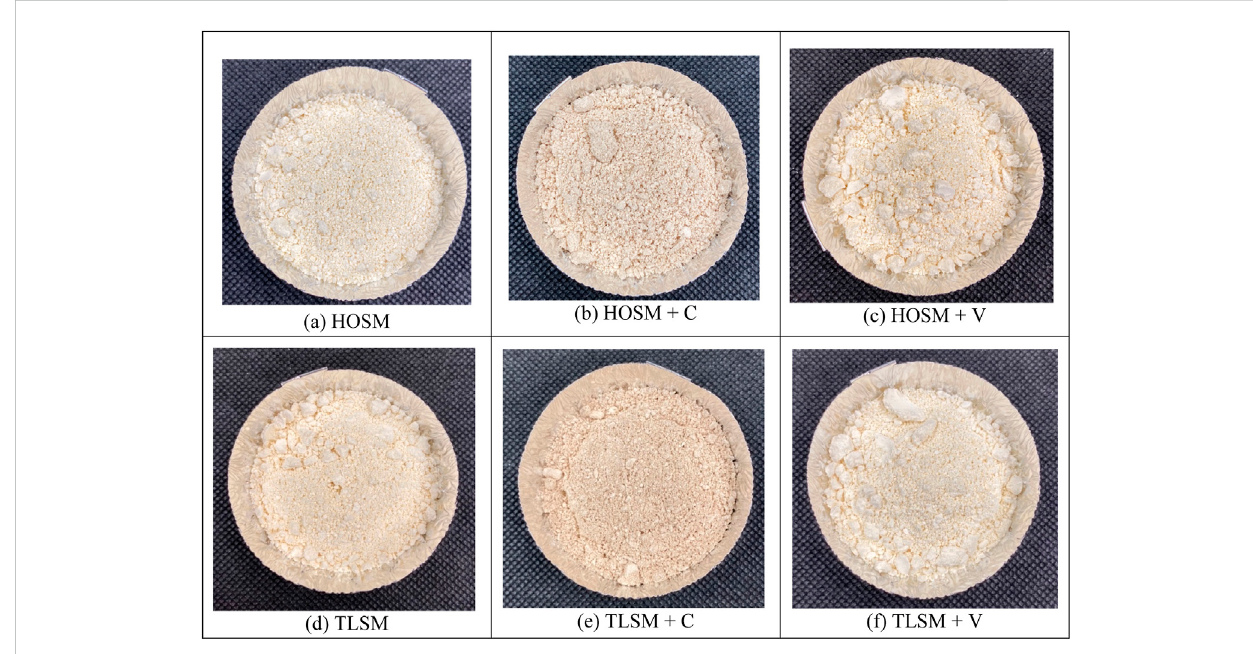
FIGURE 1 Spraydriedsoymilkpowderwithandwithout fl avoringcomponents (A) HOSM (B) HOSM+C (C) HOSM+V (D) TLSM (E) TLSM+Cand (F)